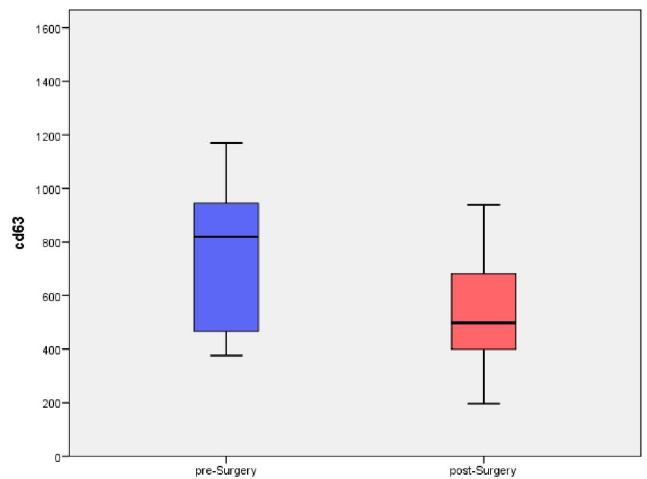
Figure 2. Box plot shows how CD63 positive plasmatic exosomes decrease after surgery from 750.88 ± 286.67 to 541.71 ± 244.93 ( p = 0.091).